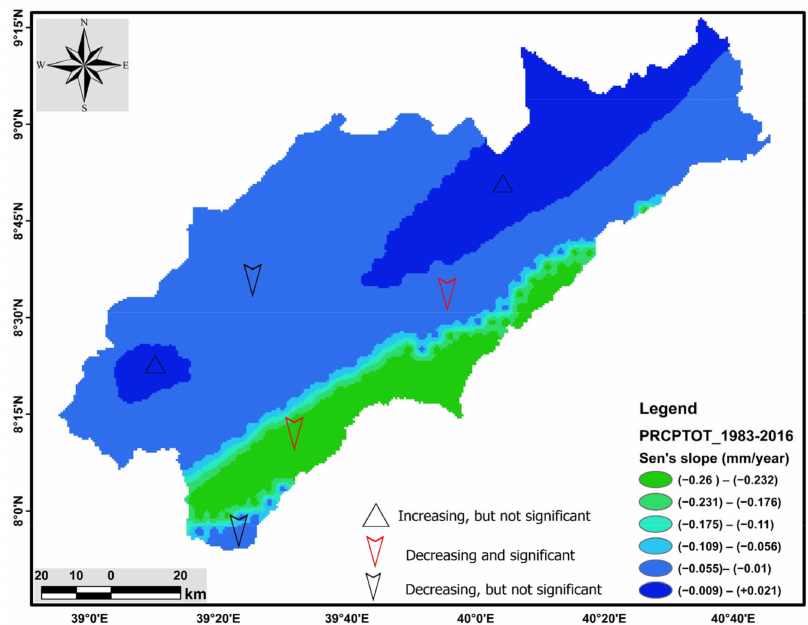
Figure 13. Annual total wet-day PRCPTOT (>1 mm/day) over agroecological zones for the period